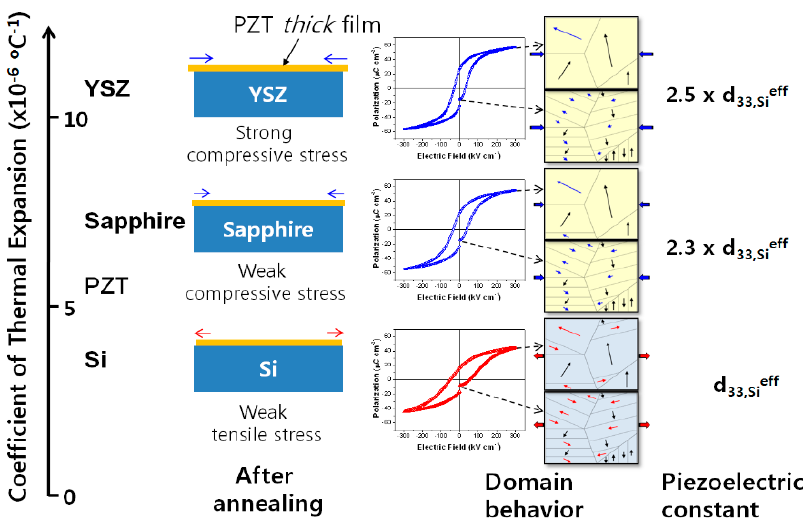
Figure 8. Schematic of high piezoelectric performance in PZT thick films deposited on various substrates; their stresses were controlled via the thermal expansion mismatch between substrates and PZT films [26]. © Copyright 2011, J. Appl. Phys.